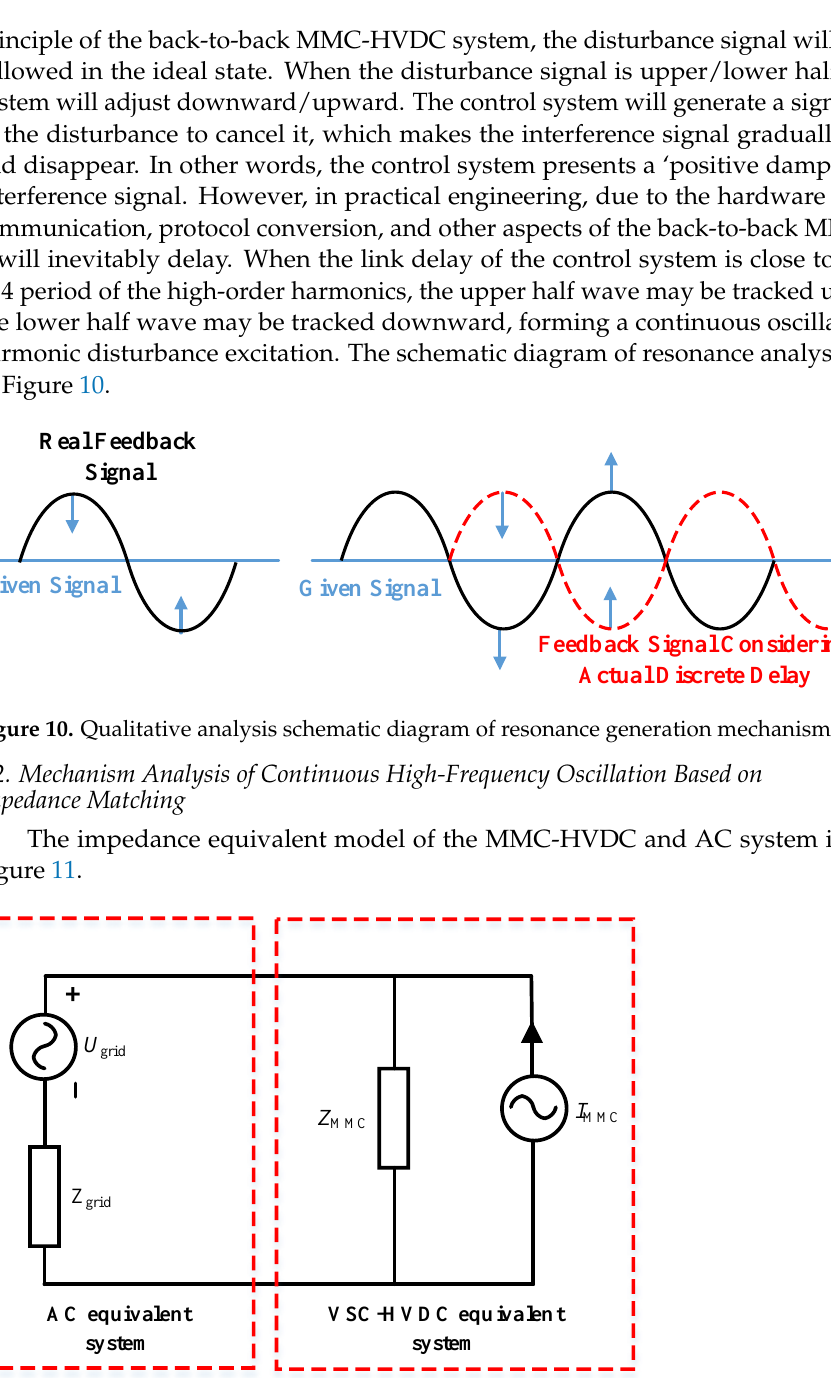
Figure 11. The equivalent impedance of the MMC-HVDC and AC system.